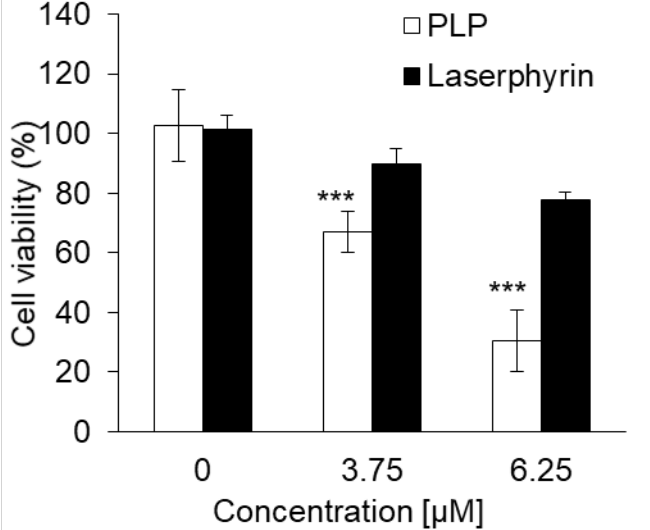
Figure 7. Cytotoxicity of PDT using PLP and laserphyrin in NOZ cells. Data are expressed as means ± SD ( n = 5). *** p <